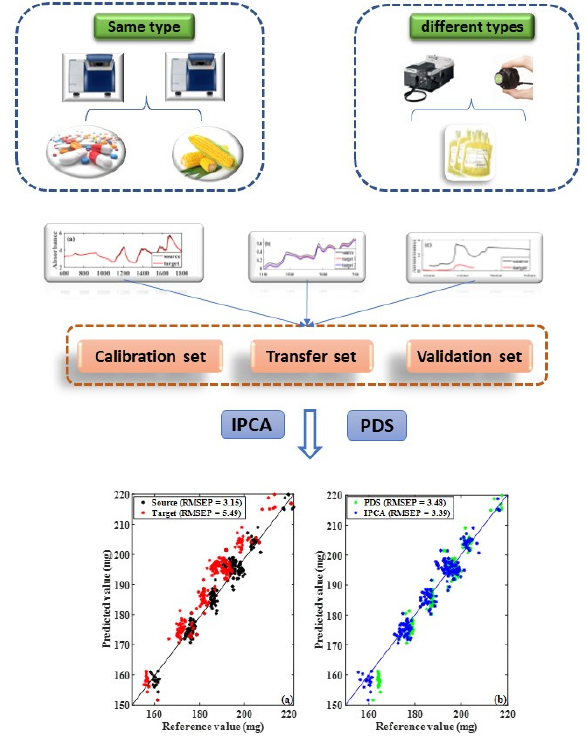
Figure 1. Schematic diagram of study.